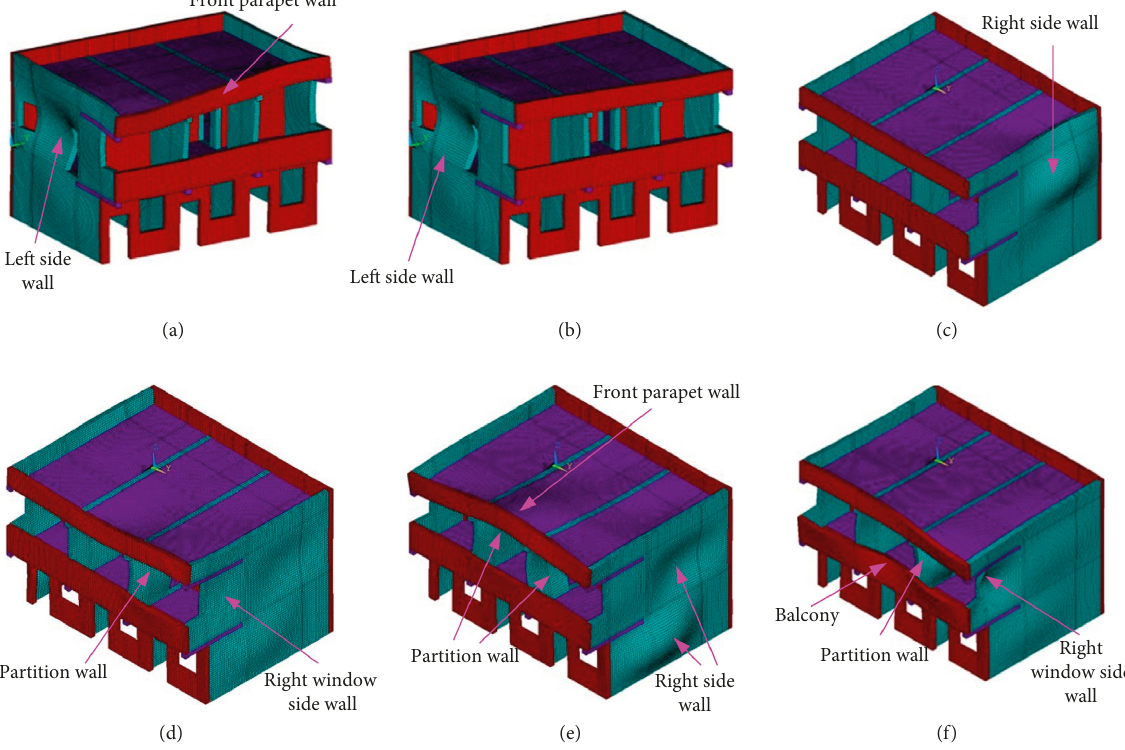
� 26.10Hz). (b) Mode 7 ( f � 26.55Hz). (c) Mode 8 6 6